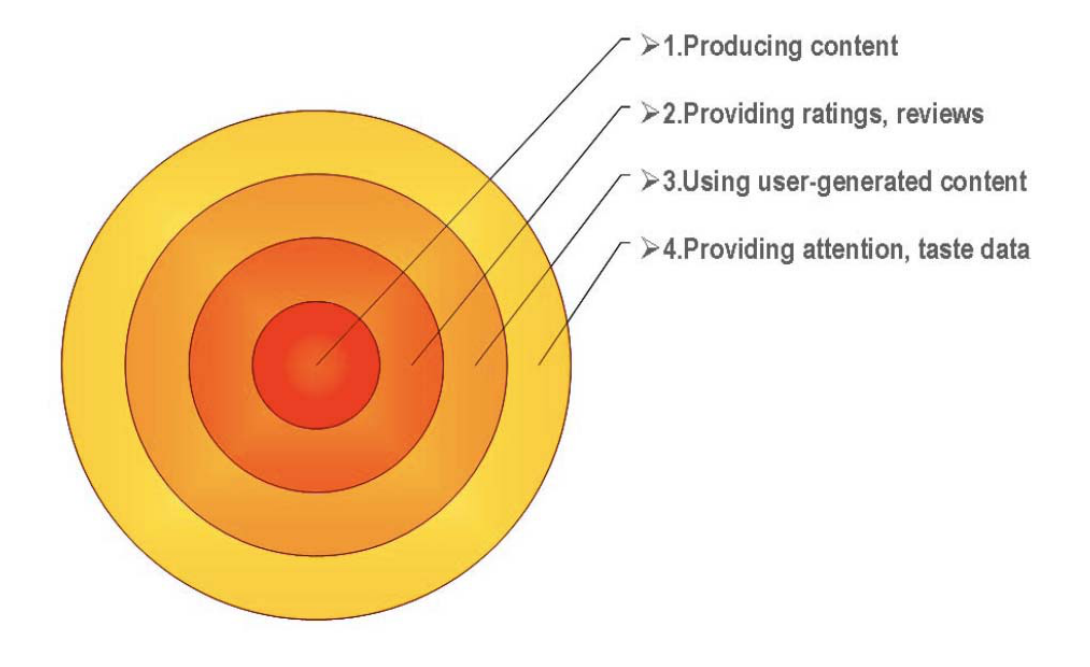
Figure 2: Categorisation of Online Users Behaviour